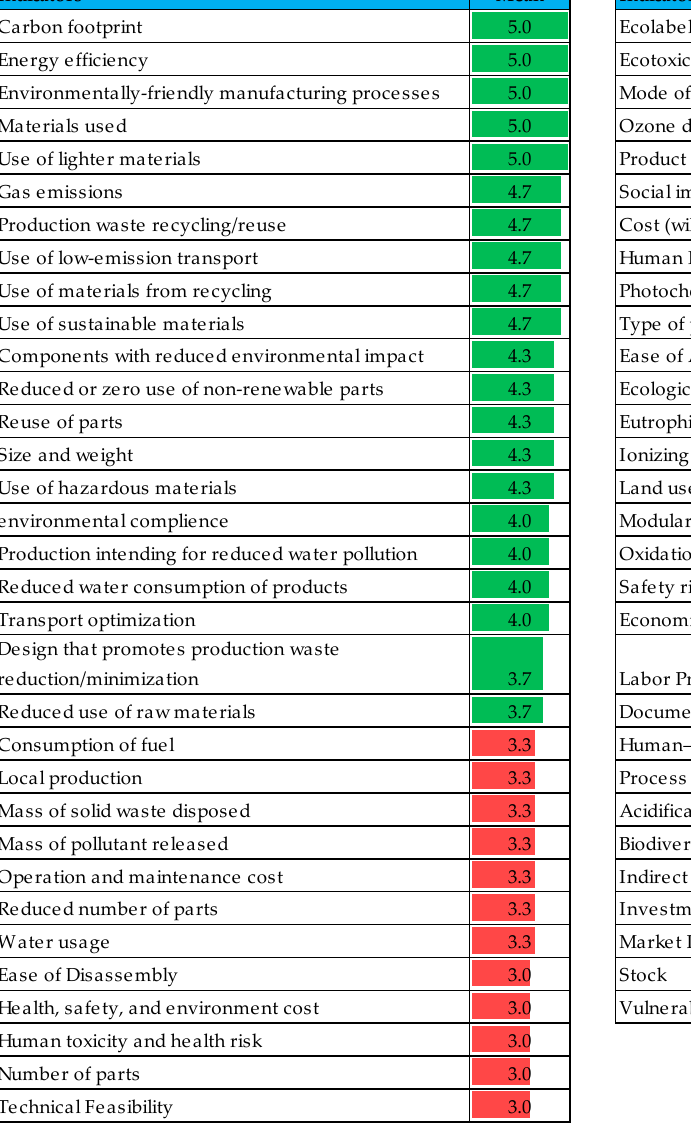
Figure 2. Initial assessment of key green indicators for the automotive industry (own elaboration).